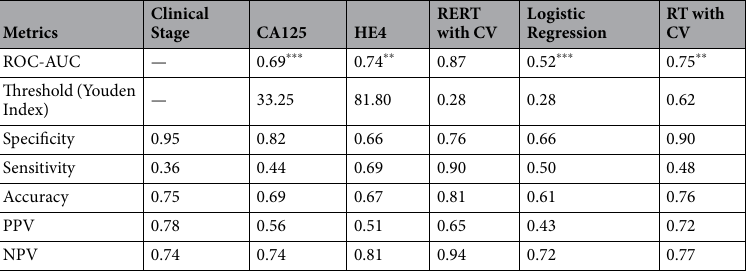
Table 2. Metrics to assess the performance of the proposed methods evaluated in all 293 EC patients. ** p-values < 0.001, *** p-values < 0.0001: these are p-values of the DeLong’s test for the comparison of two AUCs (RERT with CV vs other methods). For major details see Table S4 in Supplementary Tables. RT with CV stands for Regression Tree with